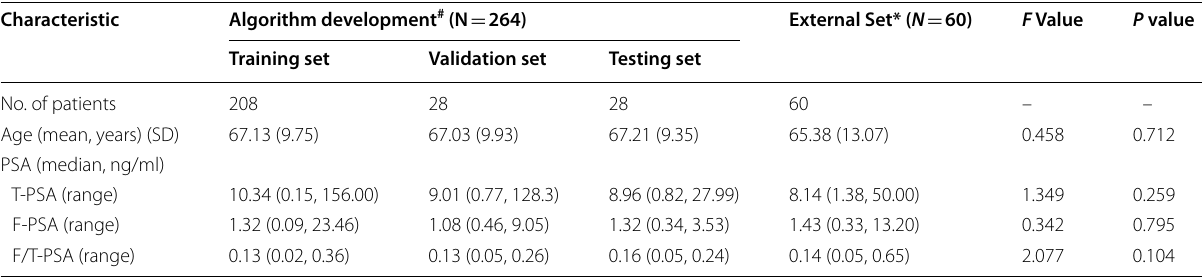
Table 2 Demographics of patients among different